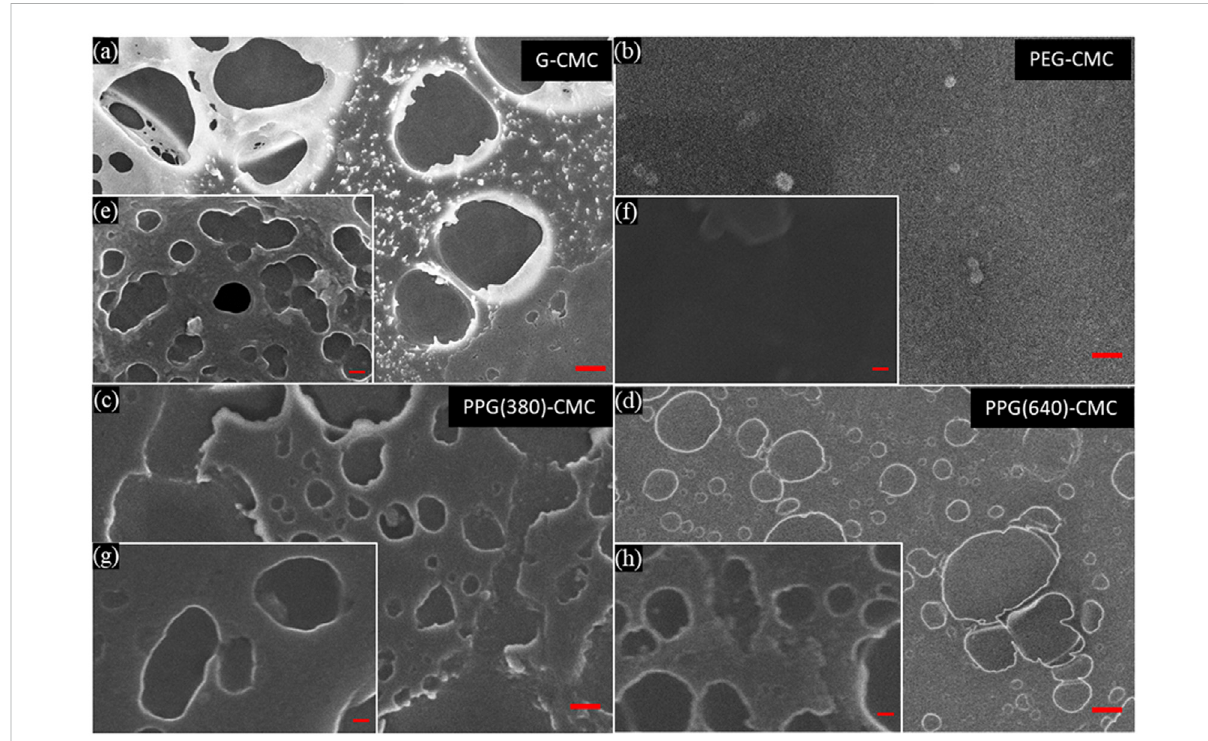
FIGURE 5 Scanning electron microscopy images of the oven dried, CMC-DE polymers, crosslinked at 70 ℃ for 2 h with a crosslinker concentration of 0.07 mol/mol. From (A – D) with 1 μ m scale bars, G-CMC, PEG-CMC, PPG (380)-CMC, and PPG (640)-CMC respectively. (E – H) are corresponding magni fi ed versions with 100 nm scale